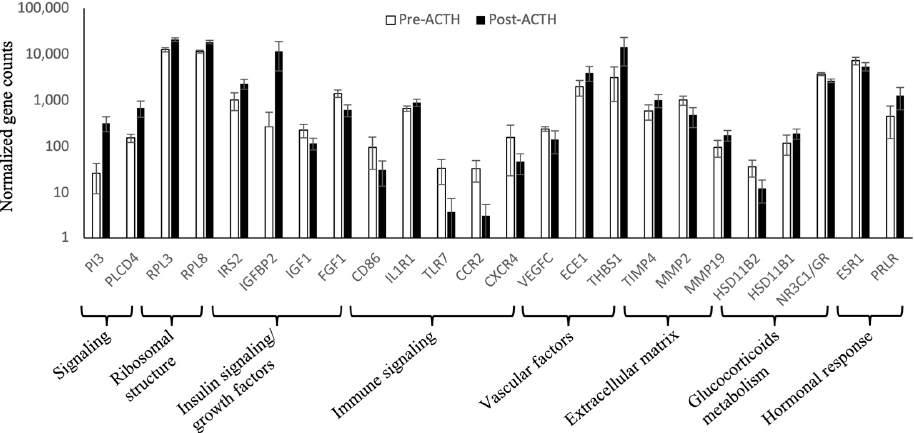
Figure 5. Graphical representation of normalized counts of selected genes. Factors involved in different biological mechanisms were selected and the data present mean ± SD of normalized counts of each gene in all samples from each group on a logarithmic scale. All factors were identified as being DEGs ( p < 0.01, FDR < 0.01) by the DeSeq2 linear model.